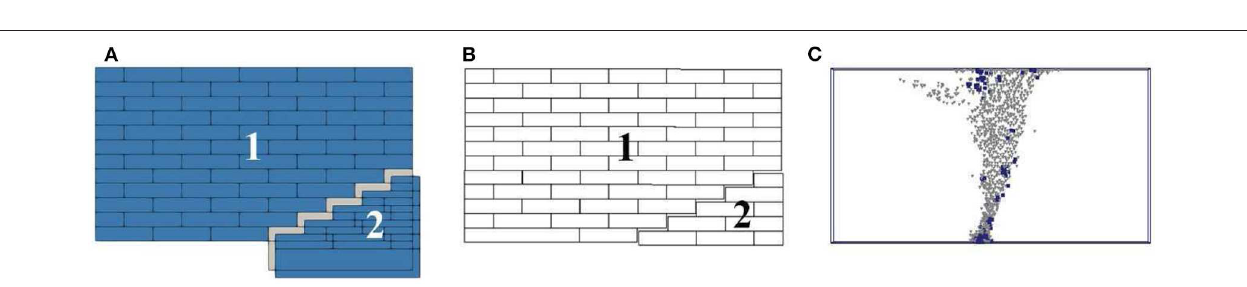
FIGURE 7 | (A) LA, (B) FEM/DEM, and (C) FEM results for Test